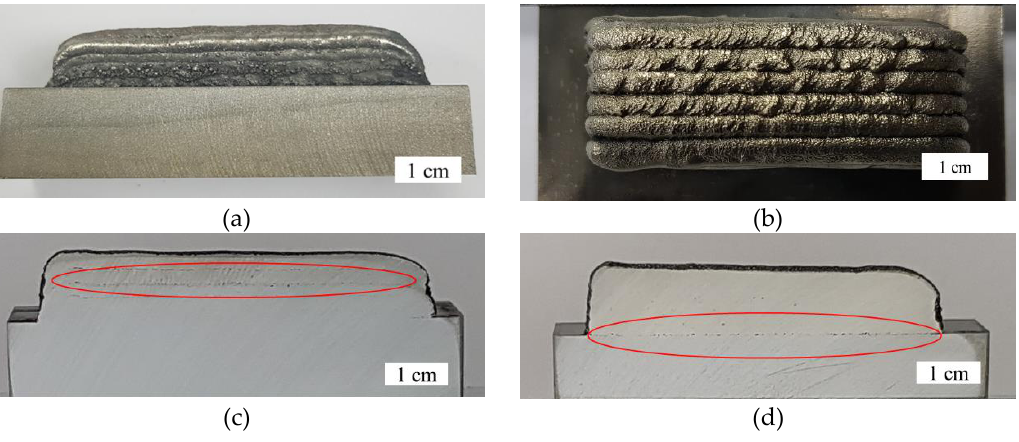
Figure 12. ( a ) Side view, ( b ) top view, ( c ) cross-section view of the sample after laser cladding of the STS316/Fe functionally graded material, and ( d ) cross-section view of the sample after dissimilar cladding between STS316 and Fe (red circle indicates pore generated region).